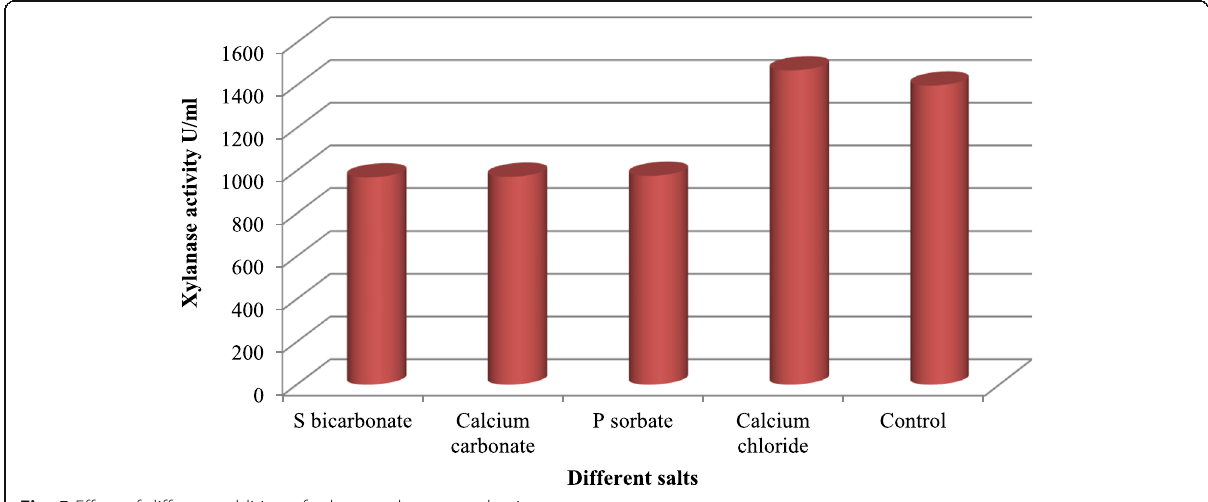
Fig. 5 Effect of different addition of salts on xylanase production